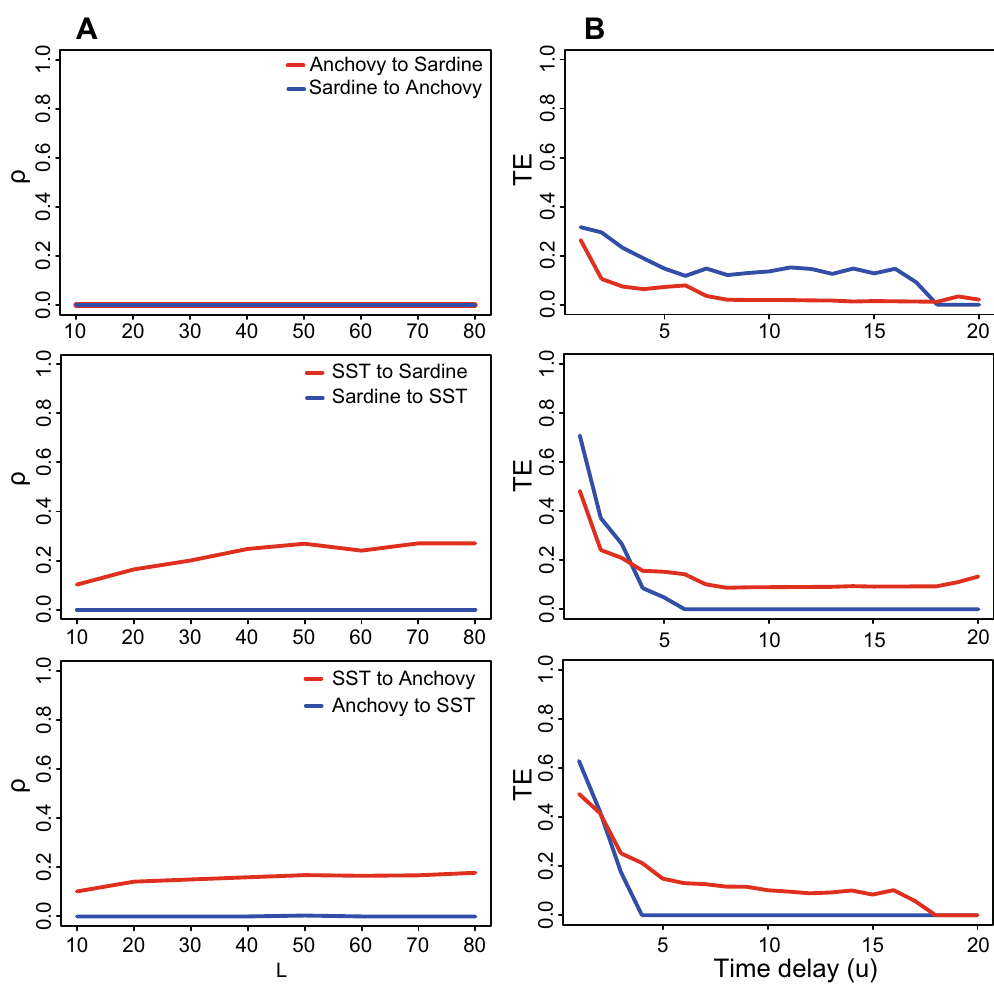
Figure 5. Inferred predictive causality for the sardine-anchovy-Sea Surface Temperature ecosystem. CCM correlation coefficient ( ρ ) and OIF predictor (TE) are shown in the left and middle plots for different pairs considered (sardine–anchovy, sardine and SST, anchovy and SST from top to